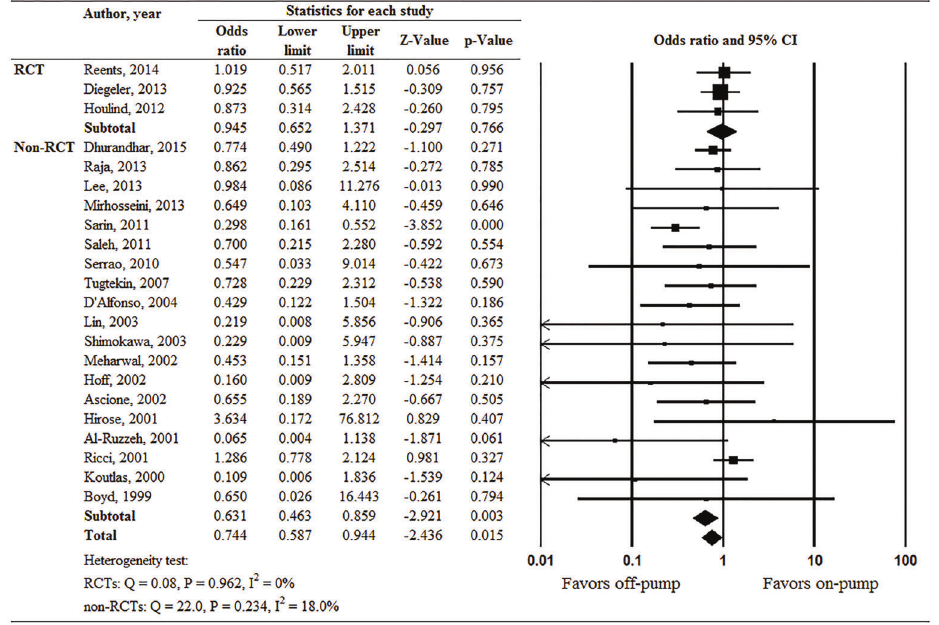
Figure 2. Summary table and forest plot of included studies for treatment effect of off-pump coronary artery bypass surgery (CABG) on mortality compared with on-pump CABG. RCT: randomized clinical trial.